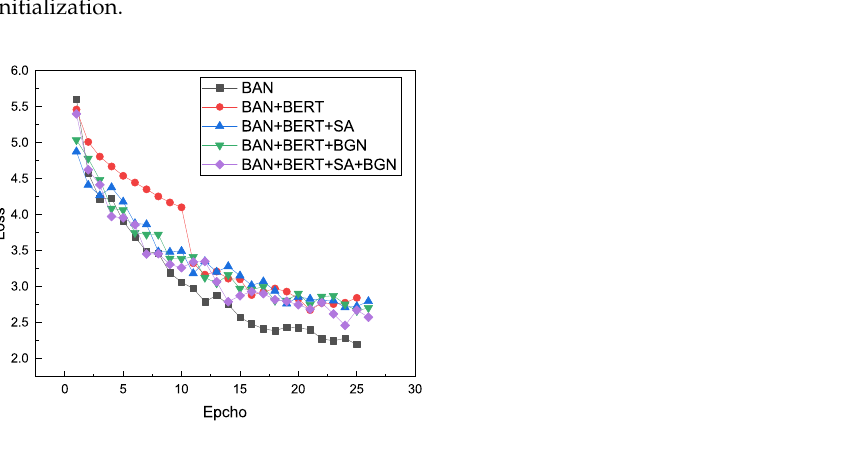
Figure 7. Loss curve of ablation model. The results are reported after using three random